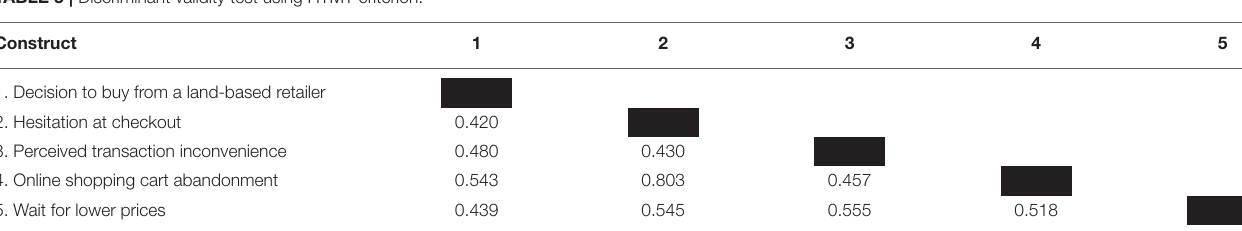
TABLE 3 | Discriminant validity test using HTMT